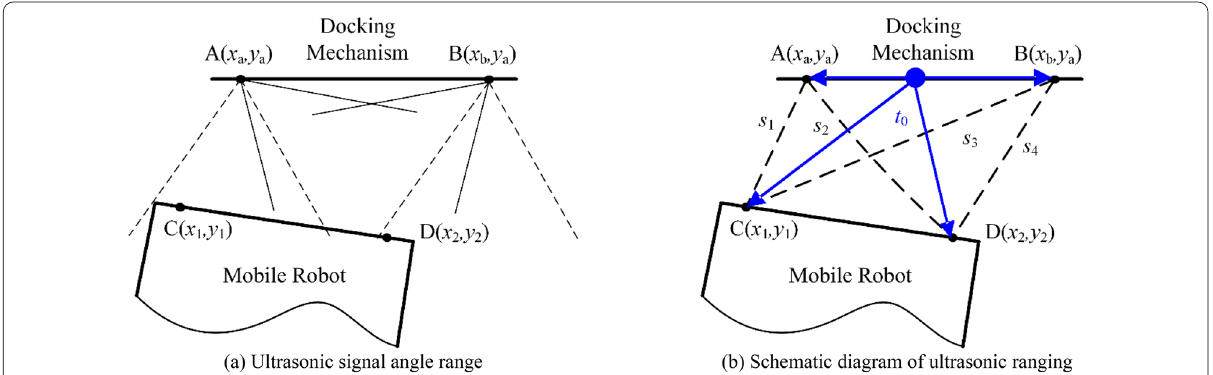
Figure 4 Dual emission dual receiver ultrasonic sensor system positioning principle +